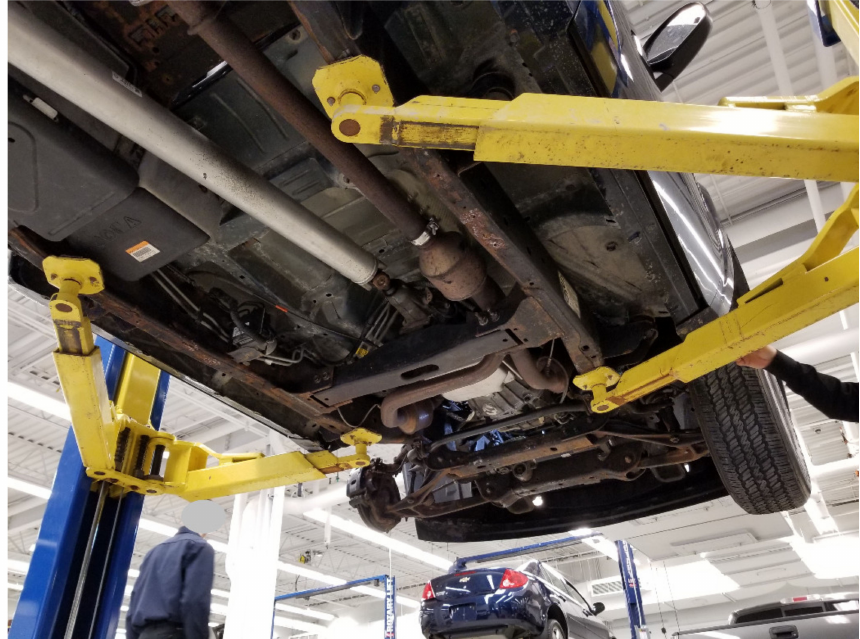
Figure 1. Vehicle raised using a 2-post above-ground automotive (2PAG) lift.